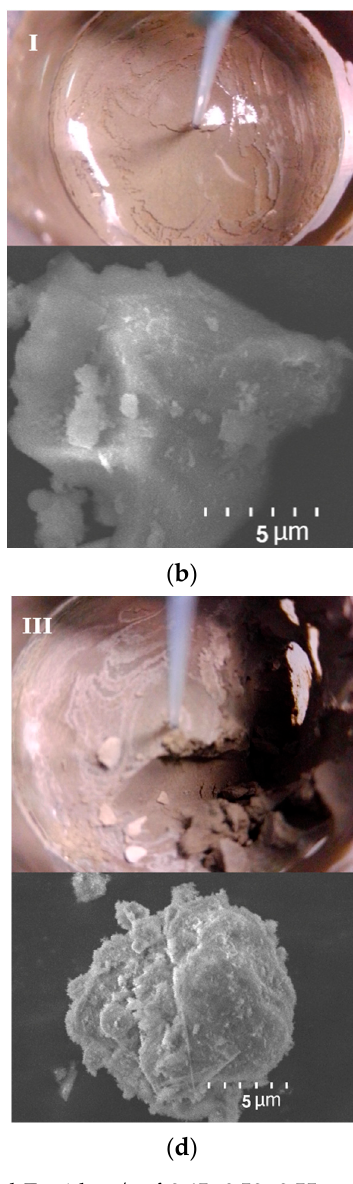
Figure 7. ( a ) Reflected light intensity from the curing of samples A, B, D and E with w/c of 0.45, 0.50, 0.55 and 0.60, respectively, accompanied by images from the cure and particles (SE images) of sample D at 1 h and 45 minutes ( b ), 3 h and 4 minutes ( c ) and 5 h and 50 minutes ( d ) after the beginning of the curing.